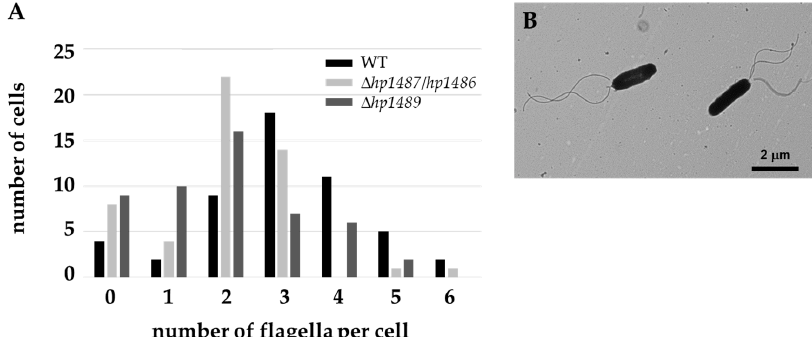
Figure 3. Flagella counts for H. pylori B128 wild type, ∆ hp1489 mutant, and ∆ hp1487 / hp1486 mutant. ( A ) H. pylori cells were visualized by TEM and flagella were counted for 50 cells. Bar graph indicates number of cells that had the particular number of flagella per cell. Both mutants produced fewer flagella per cell than wild type ( p -values < 0.01). Statistical significance was determined using a Mann-Whitney U test. ( B ) Typical H. pylori cells used for flagellar count data. Cell on the left has two flagella and cell on the right has three flagella.